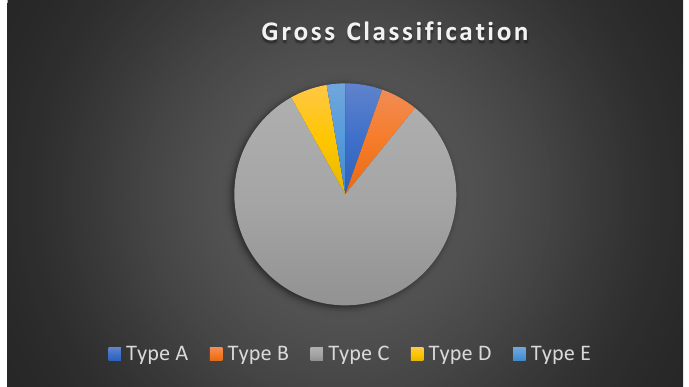
Figure 2. Distribution of tracheoesophageal fistula types among study neonates.